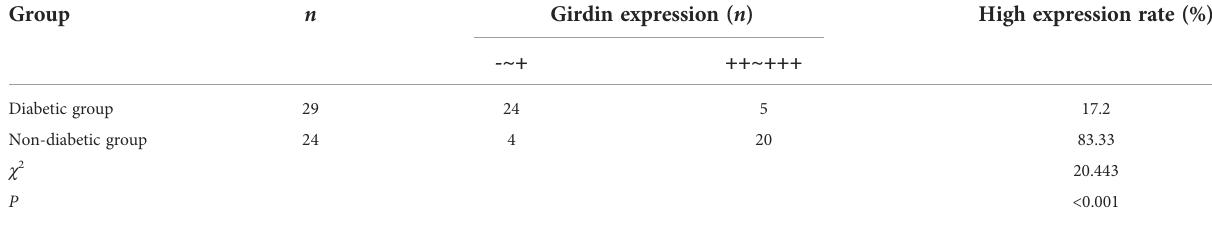
TABLE 2 Comparison of the relationship between Girdin expression and diabetic and non-diabetic patients.